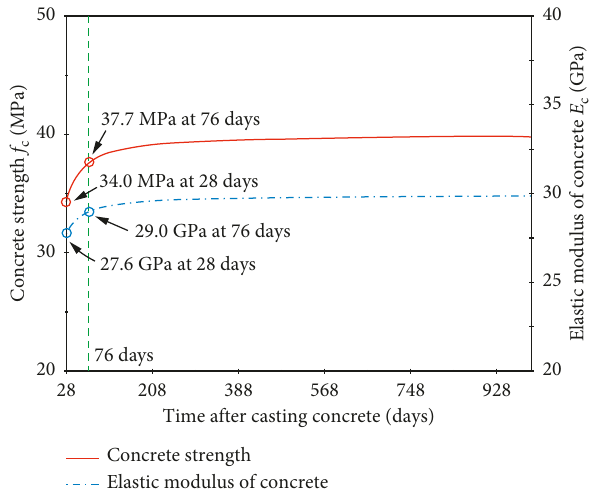
Figure 5: The evolution of concrete property with